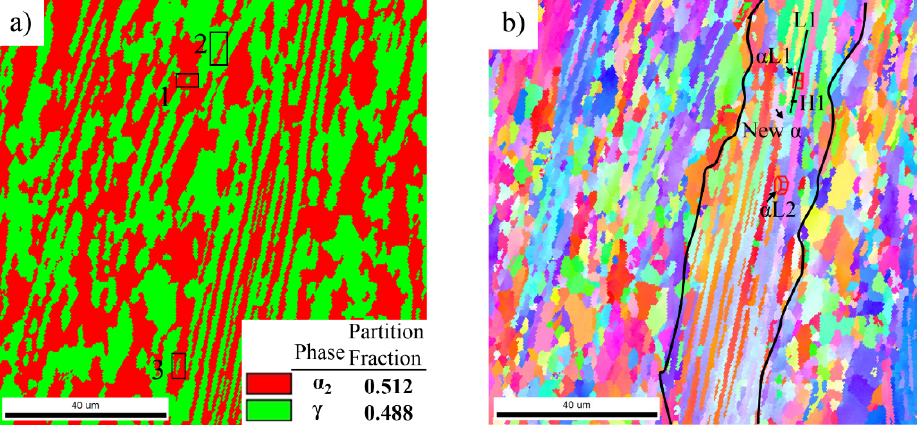
Figure 3. EBSD analysis of the quenched microstructure after three isothermal compression cycles at 1250 °C/0.1 s − 1 /25%: ( a ) phase fraction, orientation map of ( b ) α phase, ( c ) orientation map of the black region in ( a ) and ( d ) pole figure of each grain in ( c ).